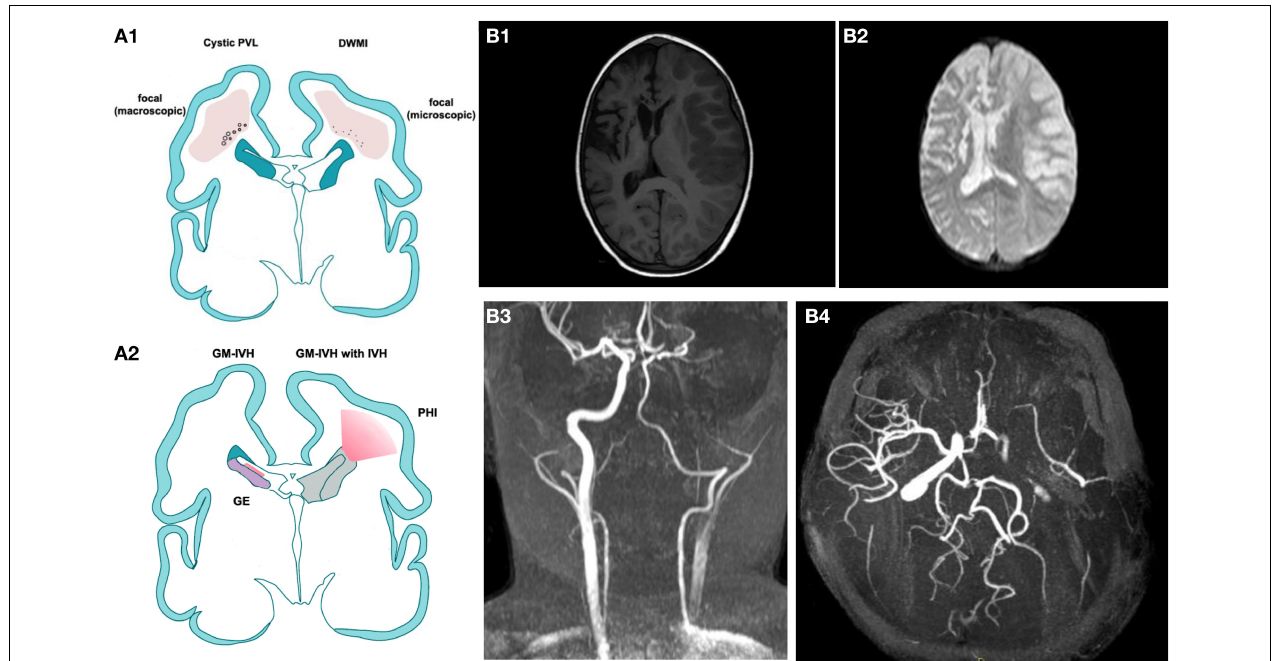
FIGURE 1 | (A) Modified by J. Volpe, Lancet Neurology 2009. (A1) Cystic Periventricular Leucomalacia (PVL) and Diffuse White Matter Injury (DWMI) and (A2) germinal matrix haemorrage-intraventricular Haemorrage (GMH-IVH) and GMH-IVH with periventricular Haemorrage infarction (PHI). Schematic coronal sections from the brain of a 28-week-old premature infant. Color key: Focal necrotic lesions in cystic PVL (small circles), focal necrotic lesions in DWMI (black dots), diffuse cellular changes in both cystic PVL and DWMI